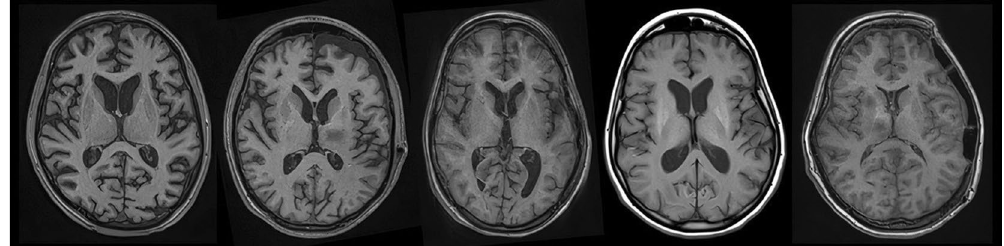
Figure 1. Initial structural MRI scans of included patients showing an absence of any large brain lesion (patients 1–5, from left to